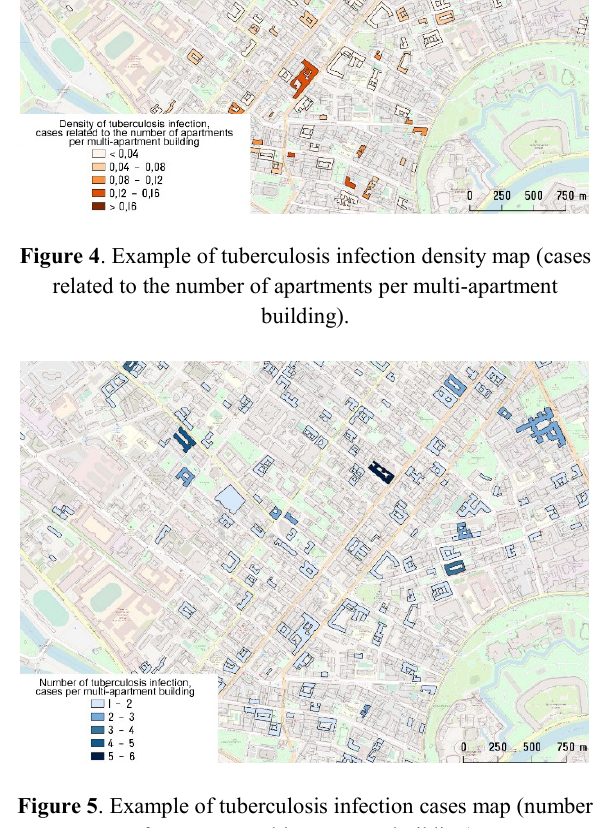
Figure 2. Web interface of the COVID-19 dashboard elaborated by Yandex company.